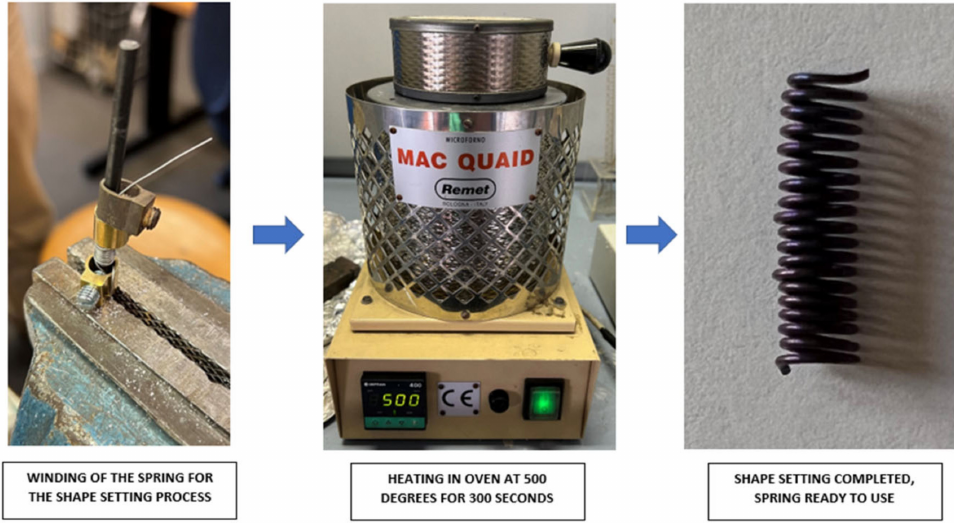
Figure 8. Shape setting process phases: wire locking on the screw, heating in the oven at 500 ◦ C, final spring with shape memory effect after quenching in